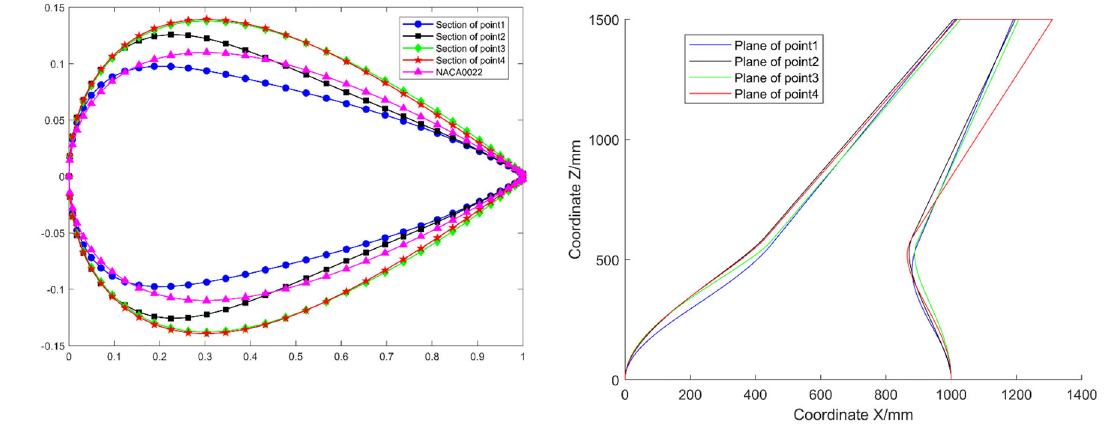
Fig. 20 Comparison of sections and planes